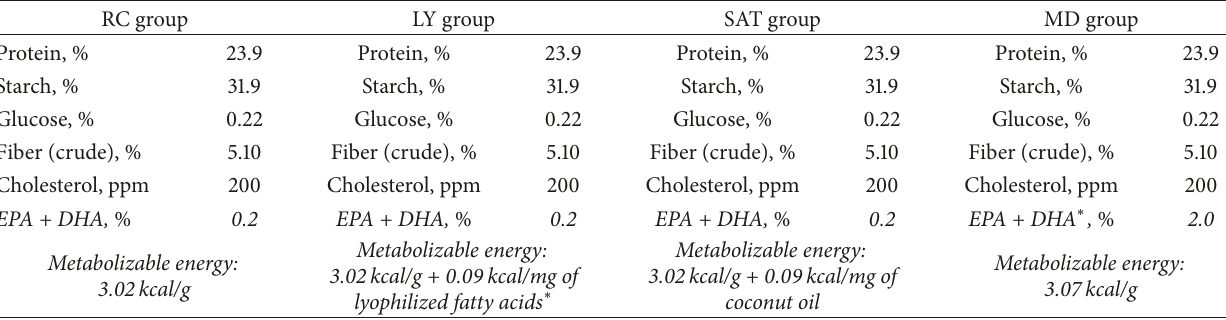
Table 1: Nutrient composition of study groups’